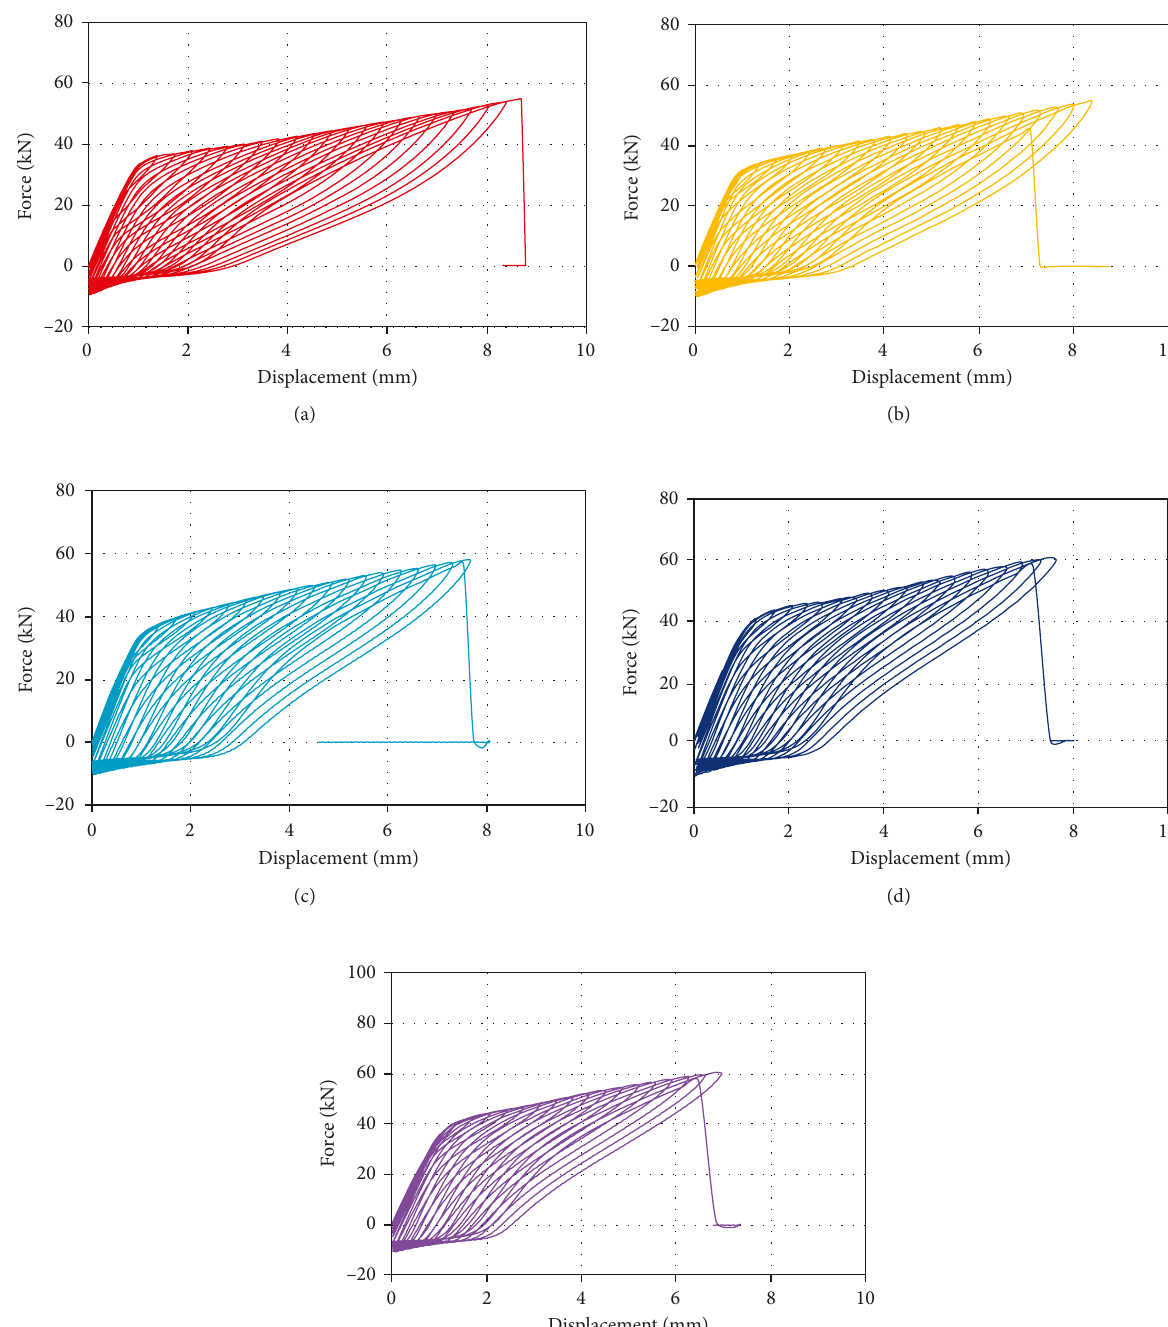
Figure 16: Force and displacement curves for SMA materials subjected to different loading speeds. (a) SMA-1 (0.033 mm/sec). (b) SMA-2 (0.165mm/sec). (c) SMA-3 (0.330 mm/sec). (d) SMA-4 (1.650mm/sec). (e) SMA-5